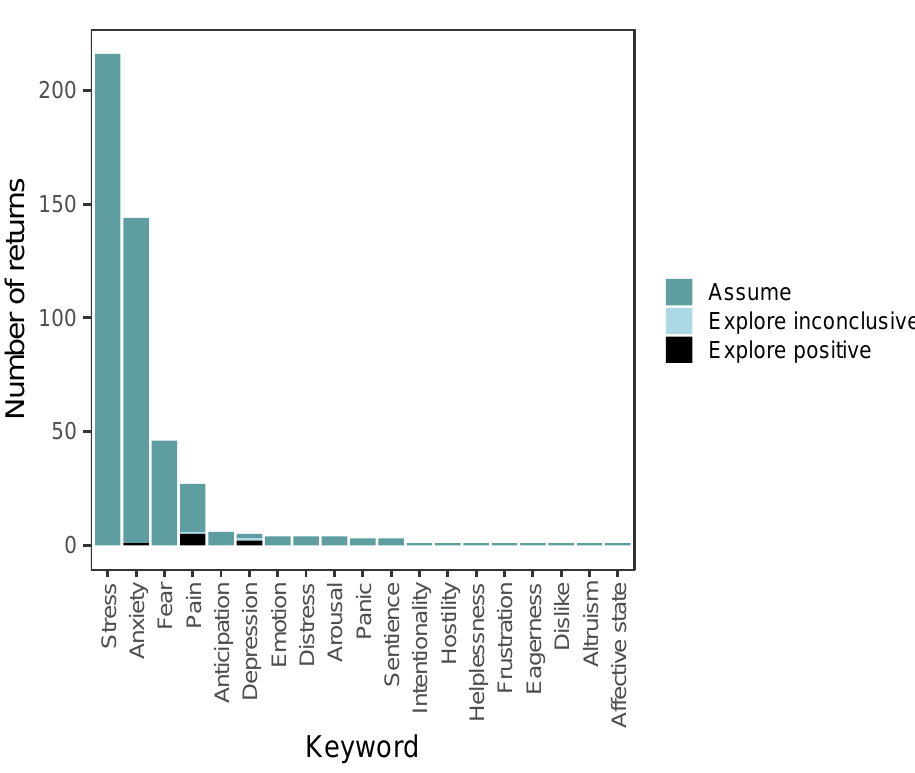
Figure 1. The number of studies returned for each of the sentience keywords we searched for in our search of the literature for evidence of sentience in fish. The graph shows the number of times each keyword was studied in fish across the 349 returned articles published between 1990 and 2020, and whether the keyword was accepted in the study (‘assume’) or was being experimentally explored.